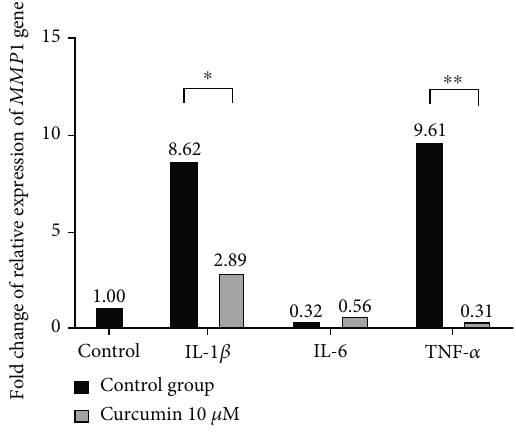
Figure 4: Representative image of gene expression analysis of performed by quantitative RT-PCR. Comparison of MMP1 gene expression in SW982 cells after 24h incubation with curcumin (10 μ M) and di ff erent cytokines (50 ng/ml). Data are presented as representative calculation from two independent experiments, ∗ p ≤ 0 : 05 , ∗∗ p ≤ 0 : 01